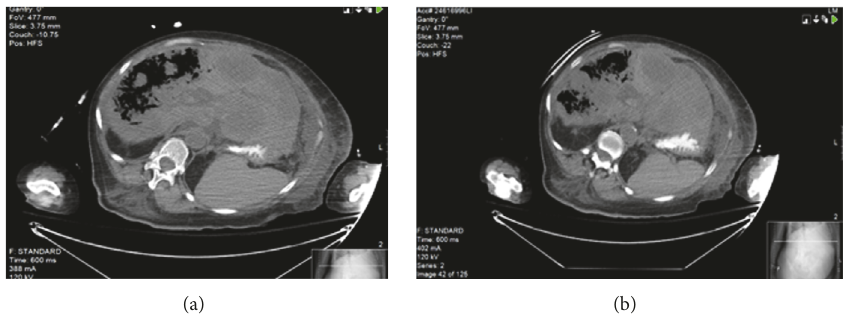
Figure 3: Showing hepatic metastasis spared by the emphysematous